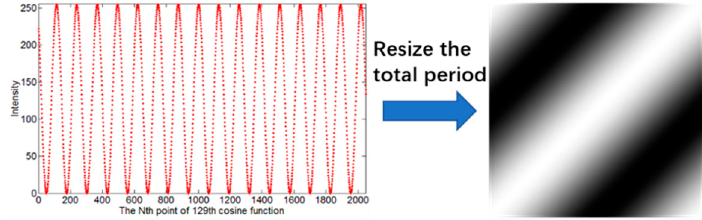
Figure 1. Resizing a row of the real part of the Fourier matrix to generate a 2D pattern.